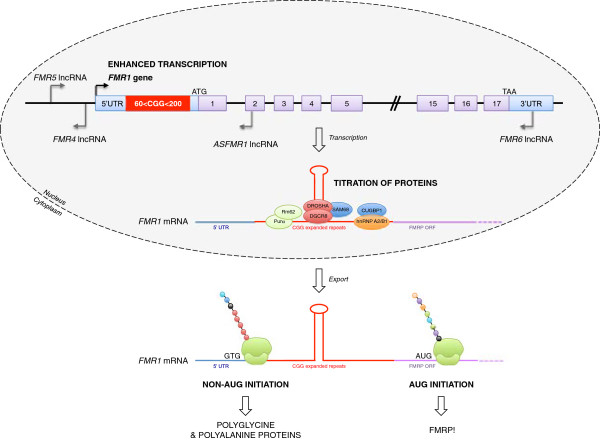
Mechanisms that may contribute to fragile X-associated tremor/ataxia (FXTAS) pathology. Expression of FMR1 mRNA and associated antisense transcripts are increased inpremutation carriers. Some transcripts accumulate in the nucleus and recruit various RNA binding proteins, while export and non-AUG translation results in production of polyglycine-containing or polyalanine-containing proteins.